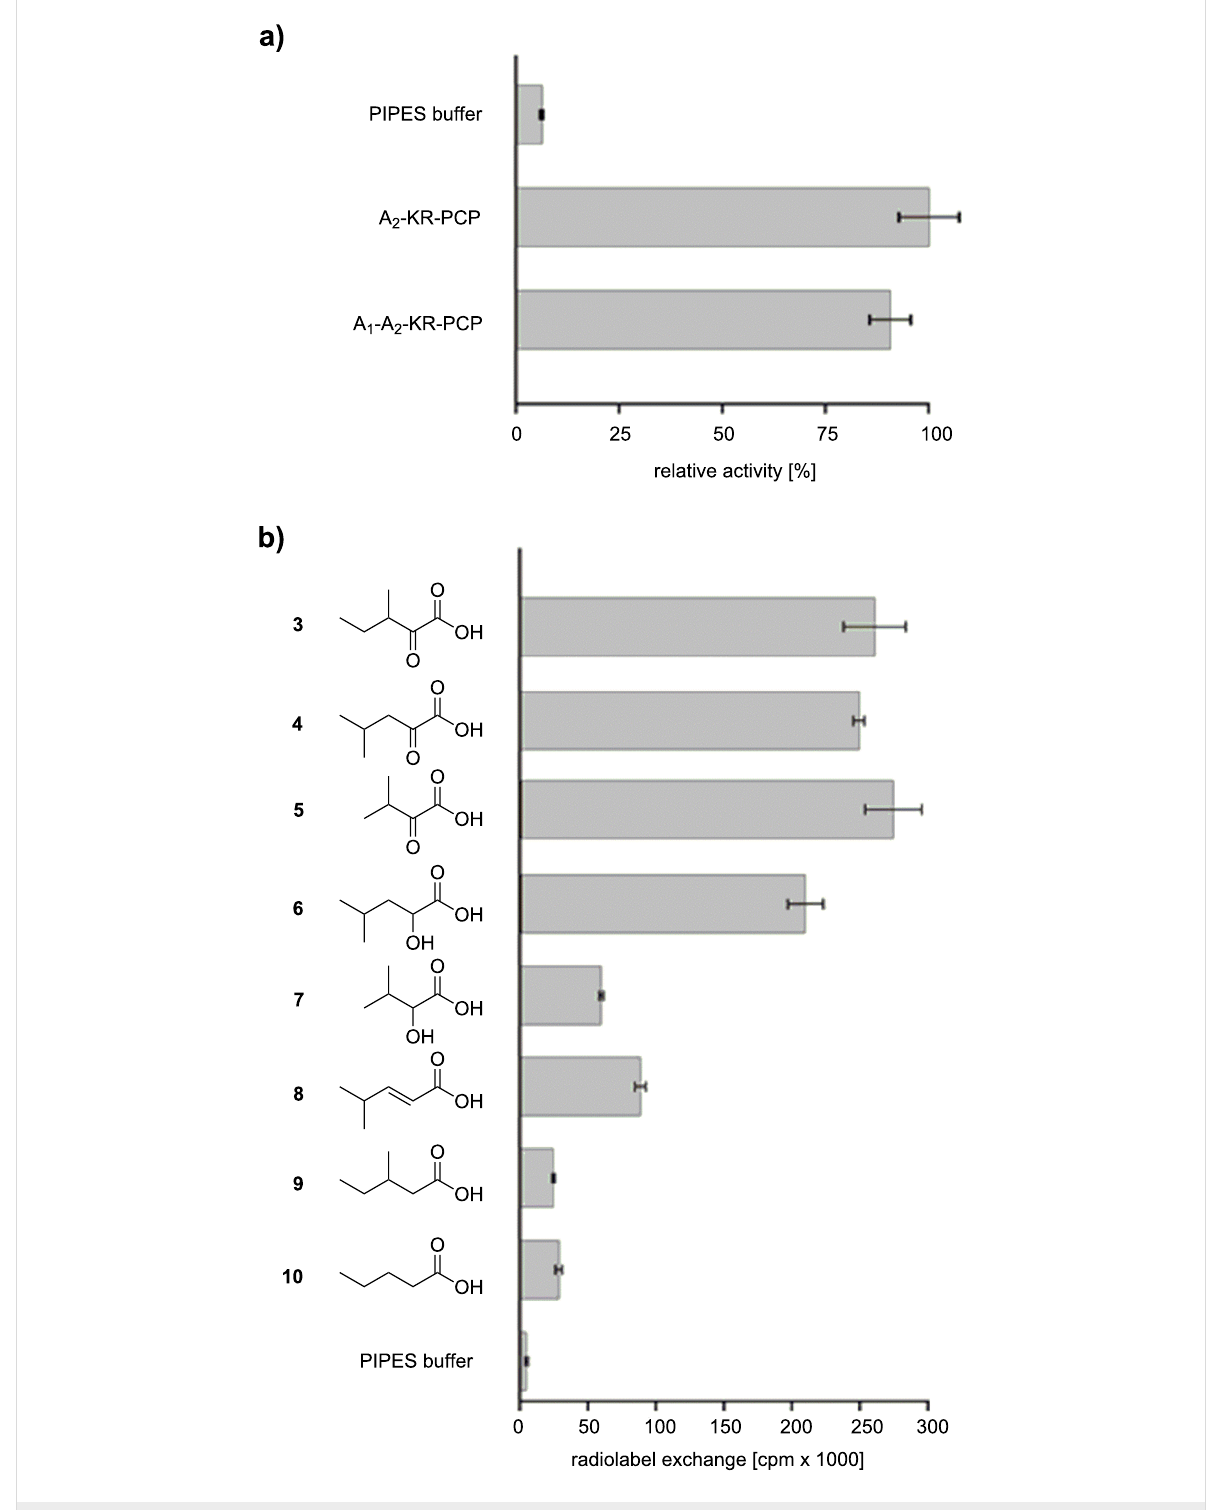
Figure 3: Testing of AulA (A 1 -A 2 -KR-PCP) and a truncated variant (A 2 -KR-PCP) in the ATP-[ 32 P]pyrophosphate exchange assay using 3-methyl-2- oxovaleric acid as a substrate. Relative activities are referenced to the A 2 -KR-PCP enzyme (a). Substrate specificity of recombinant AulA in the ATP- [ 32 P]pyrophosphate exchange assay (b). All bar diagrams depict the substrate-dependent exchange based on the arithmetic mean of triplicate reac- tions. Error bars represent the standard deviations. Substrates with chiral centres were tested as racemic mixtures. PIPES buffer was used as nega- tive